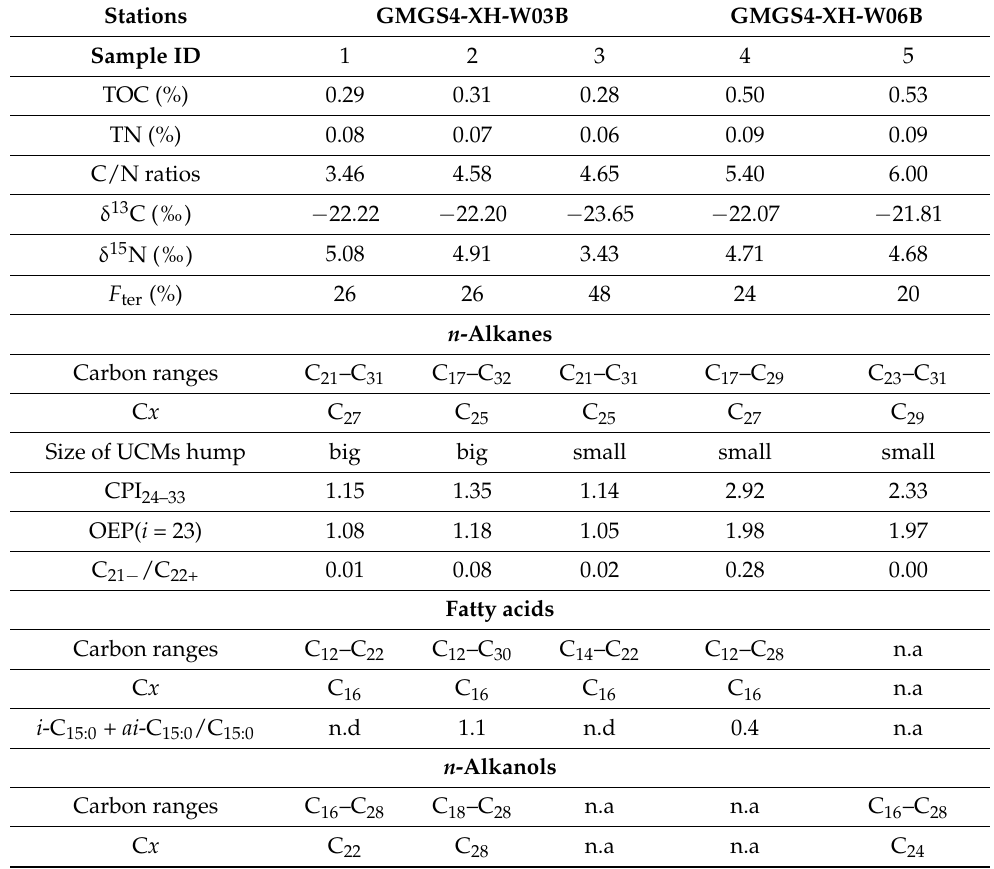
Table 2. Analytical results of the bulk geochemical parameters and biomarker ratios for sediment